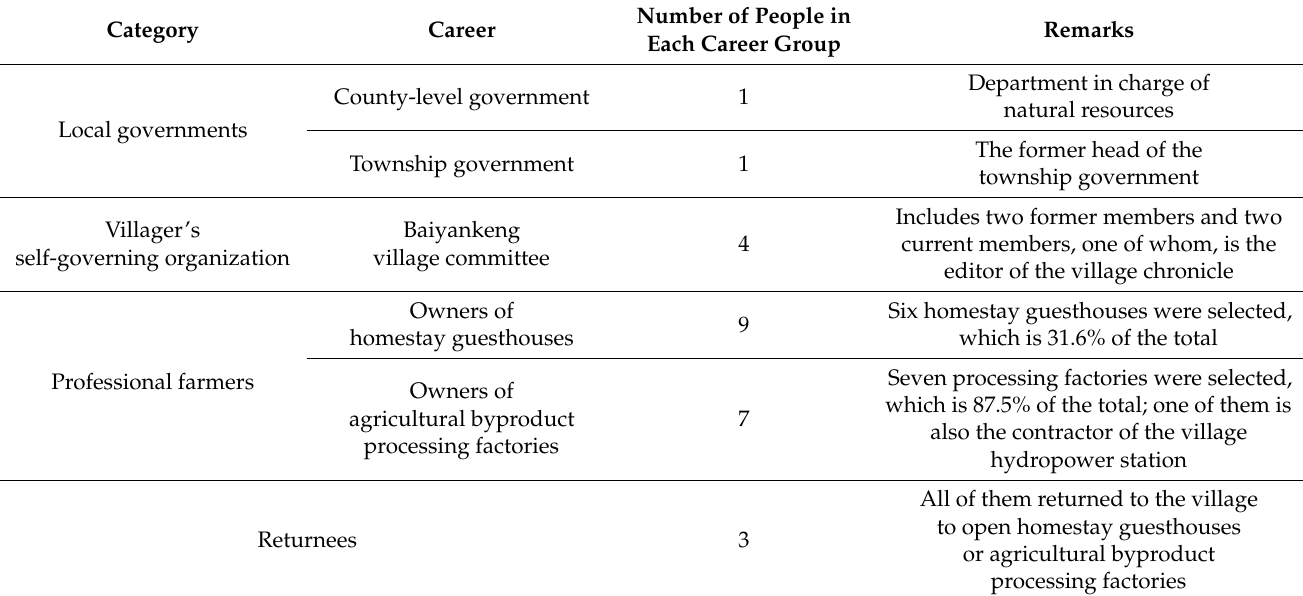
Table 2. The basic attributes of